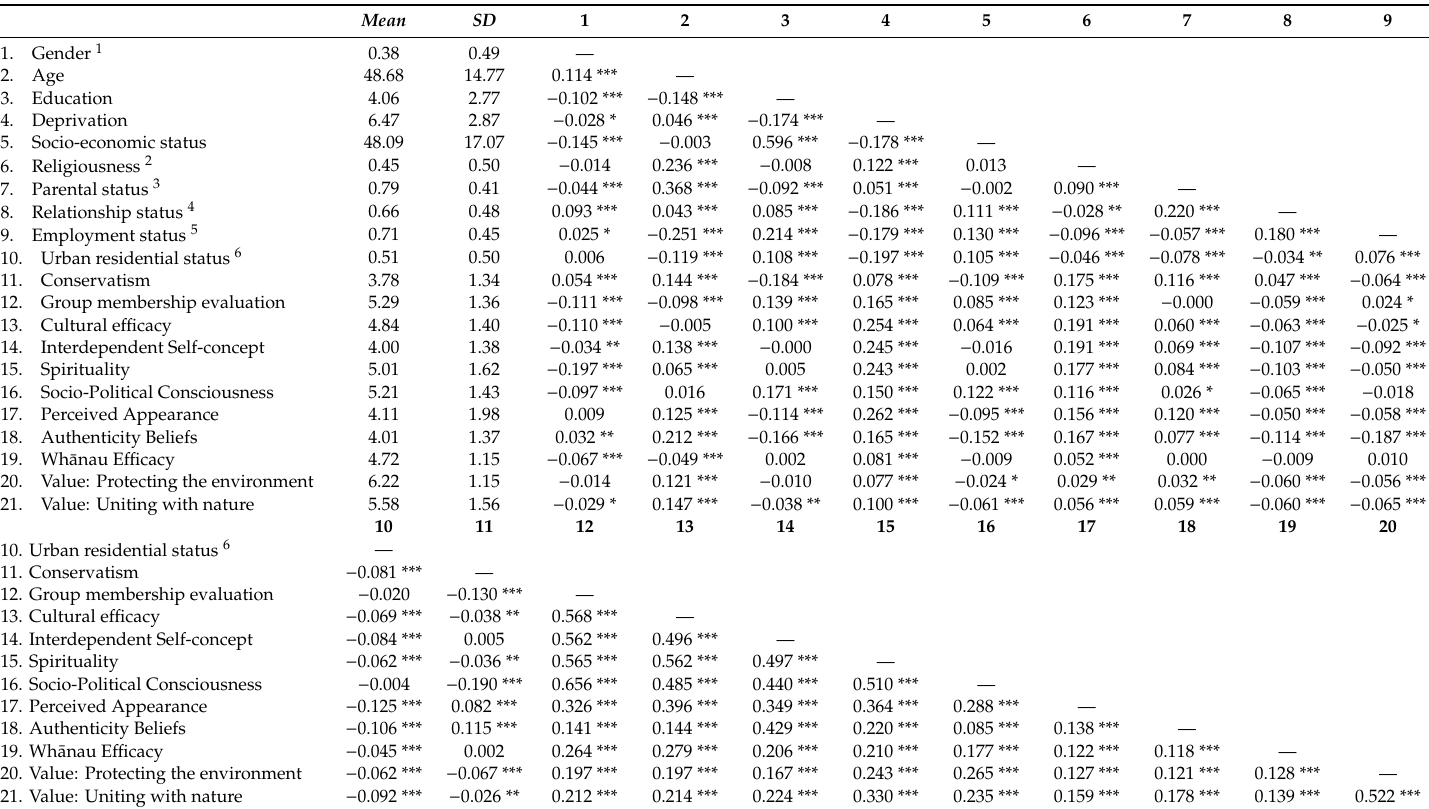
Table 1. Descriptive statistics and bivariate correlations for variables of